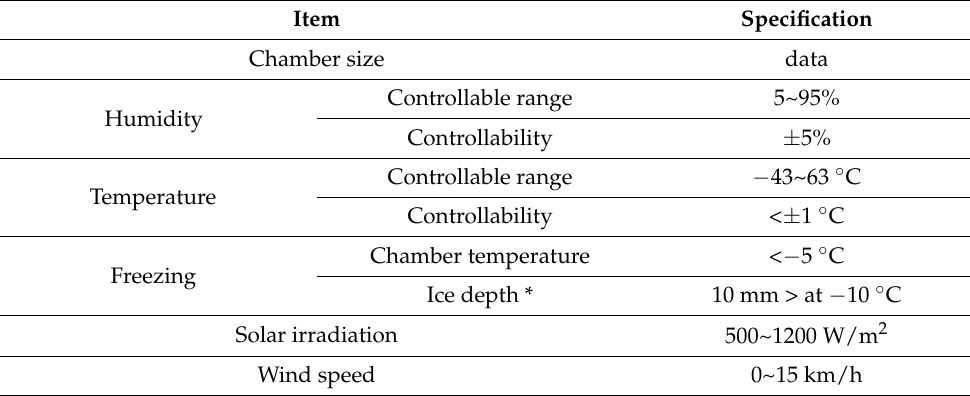
Table 2. Operating specifications of real-scale environmental chamber.